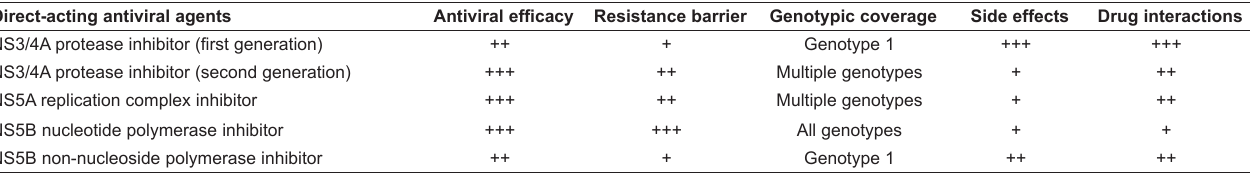
TAble 2 General characteristics of direct-acting antiviral agents Direct-acting antiviral